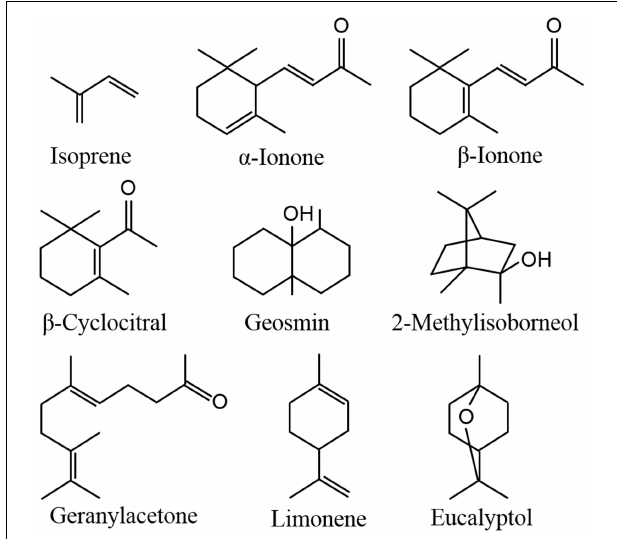
FIGURE 1 | Chemical structures of some main terpenoids in algal